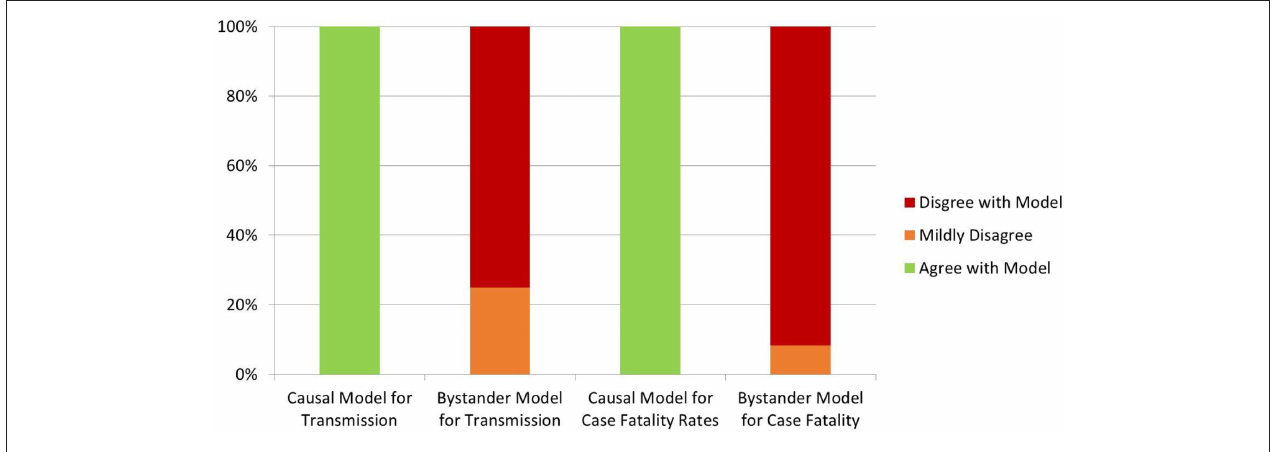
FIGURE 4 | Davies et al., Causal model results